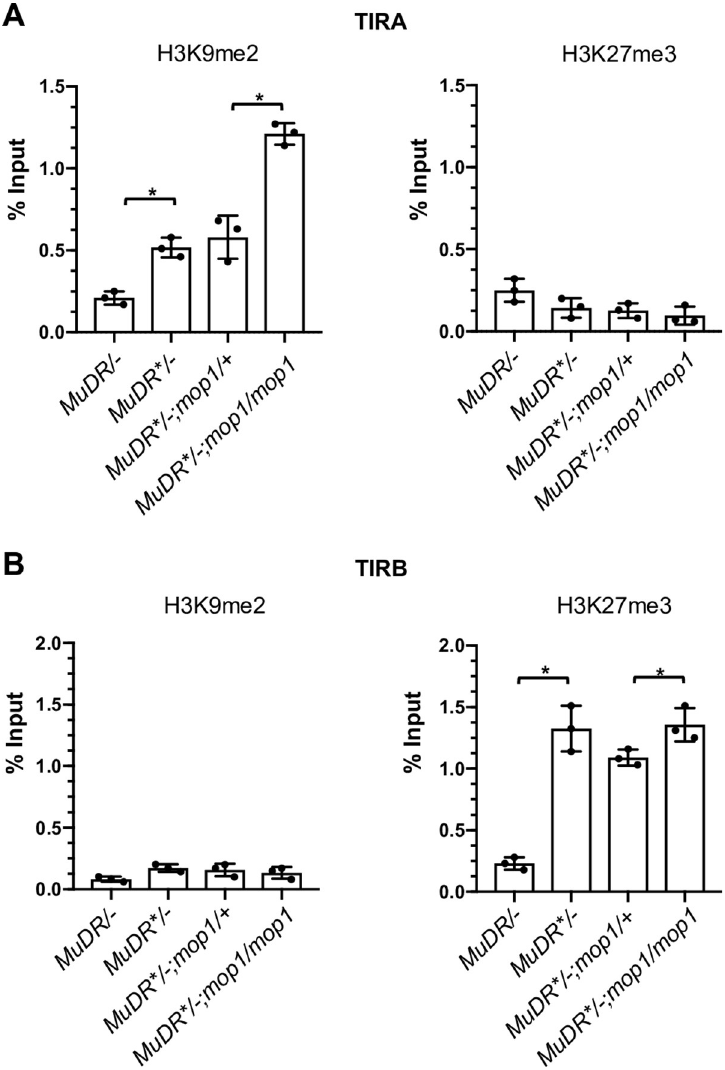
Fig 2. ChIP-qPCR analysis of enrichment of histone marks H3K9me2 and H3K27me3 at TIRA and TIRB in mop1 mutants. ChIP-qPCR analysis of enrichment of histone marks, H3K9me2 and H3K27me3 at TIRA and TIRB. (A) Relative enrichment of H3K9me2 and H3K27me3 in leaf 3 of plants of the indicated genotypes. MuDR : active element. MuDR � : inactive element. (B) Relative enrichment of H3K9me2 and H3K27me3 in leaf 3 of plants of the indicated genotypes. qPCR signal was normalized to Copia and then to the value of input sample. An unpaired t-test was performed. Error bars indicate mean ± standard deviation (SD) of the three biological replicates. � P < 0.05; �� P <